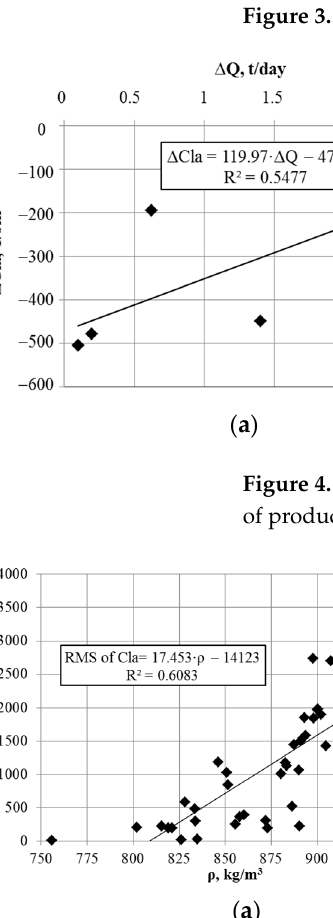
Figure 5. Relationship between RMS of Cla and density ( a ) and dynamic viscosity ( b ) [102].